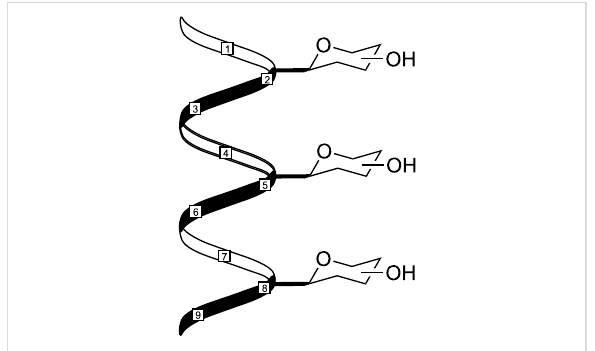
Figure 1: Sketch of right-handed β -peptide helix functionalized in every third amino acid by carbohydrates presenting equidistant sugar units with uniform orientation in 5 Å